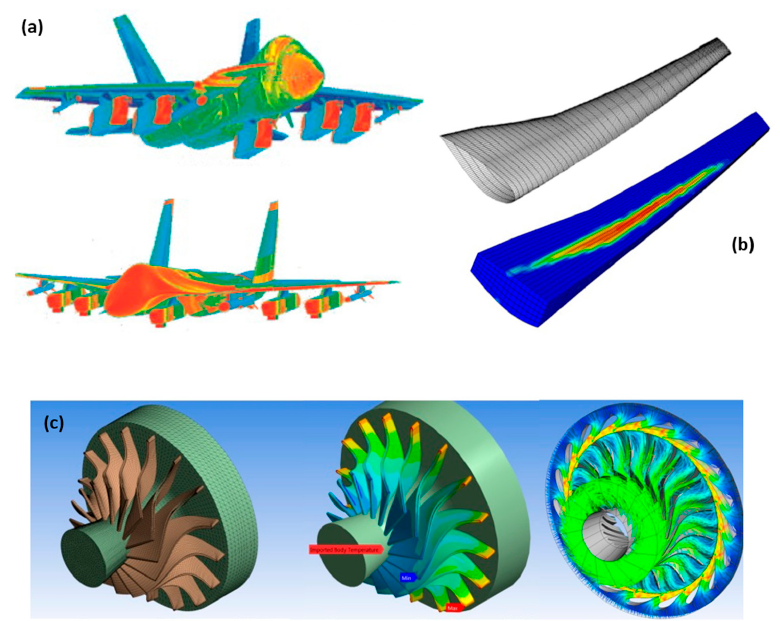
Figure 39. Some applications of FEM in composites in the aeronautical industry: ( a ) fluid–structure. Reproduced with Creative Common License [288], ( b ) wing geometry. Reproduced with permission [289] and ( c ) tube rotor blade improvement. Reproduced with Creative Common License [290].